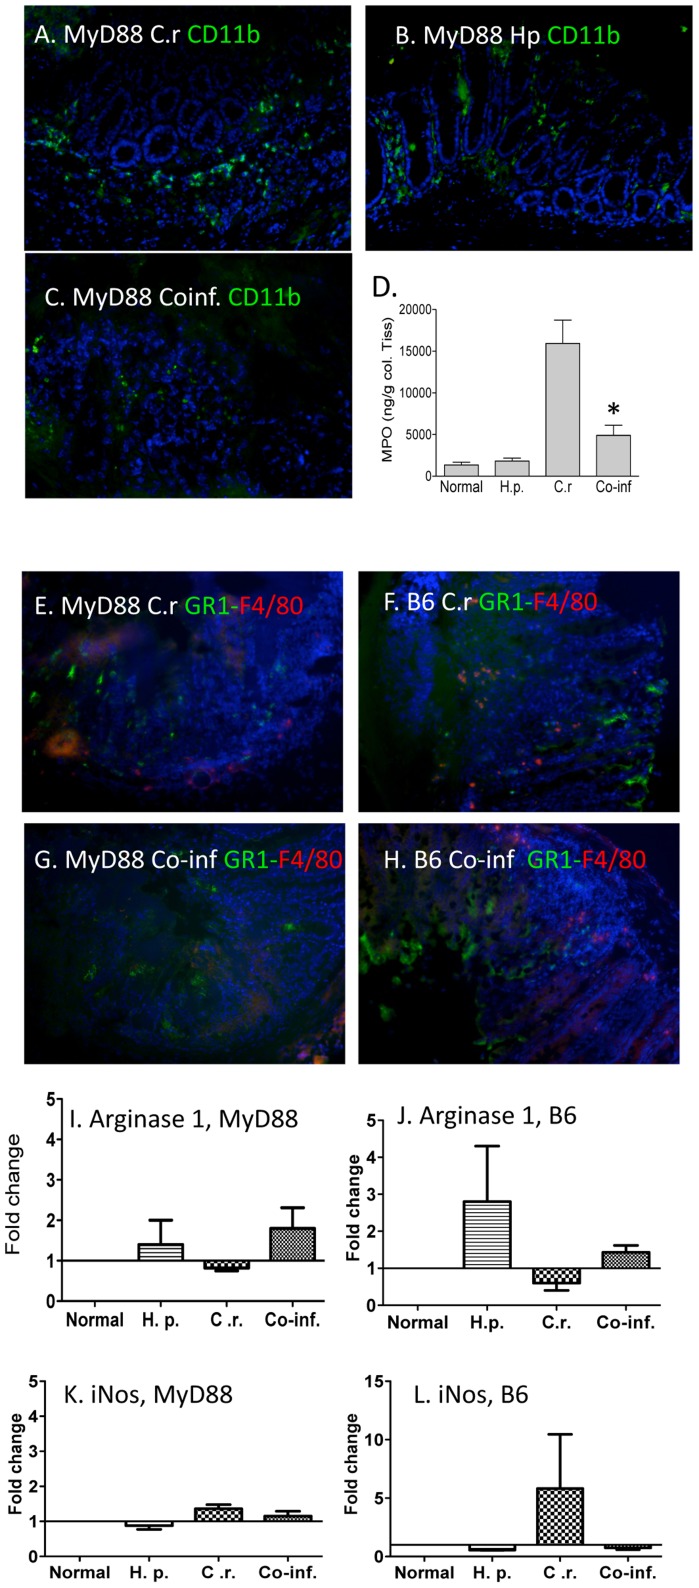
Helminth co-infection results in decreased number of CD11b+ cells and antimicrobial peptide expression in colonic tissue.
A–C, MyD88 knockout mice were infected with H. polygyrus and inoculated with C. rodentium orally 7 days later. Mice infected with C. rodentium (C.r) (A), H. polygyrus (Hp) (B) and both (Co-inf) (C) were sacrificed. Histological sections of the colon were stained with anti-CD11b-FITC (green) and DAPI (blue), and analyzed by immunofluorescence microscopy. Magnification, ×100. D, Colonic tissue MPO level was determined by ELISA. E–H. Colon tissues were collected from C. rodentium-infected (E: MyD88 knockout; F: C57BL/B6) and co-infected (G: MyD88 knockout and H: C57BL/B6) mice and stained with anti-GR1-FITC (green), anti-F4/80 (red) and DAPI (blue), and analyzed by immunofluorescence microscopy. All images were digitized and cropped in Adobe Photoshop LE 5.0 (Adobe Systems). I–L:Colon tissues were collected from normal control, C. rodentium-infected, H. polygyrus infected, and co-infected wild-type C57BL/6 and MyD88 knockout mice. The expression of Arginase 1, a marker for alternatively active macrophages, was determined in MyD88 knockout mice (I) and B6 mice (J) using quantitative RT-PCR. iNOS expression was determined in MyD88 knockout mice (K) and B6 mice (L). Values are the fold increase compared with baseline obtained from uninfected mice. The data shown are the mean ± the SEM (n = 3–5 mice/group) from one of three experiments performed showing similar results. *p<0.05.